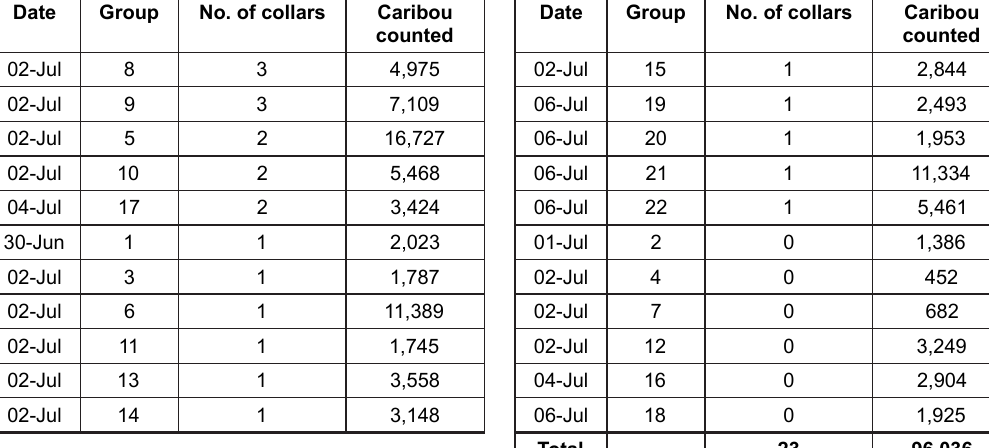
Table 1. Field data for the Bluenose-East 2000 post calving survey.